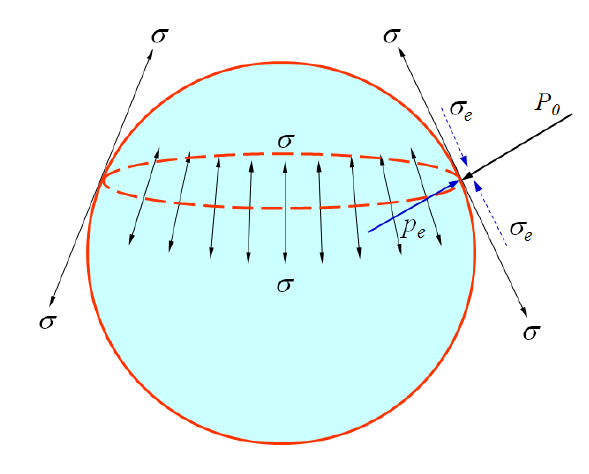
Figure 1. Forces on a charged